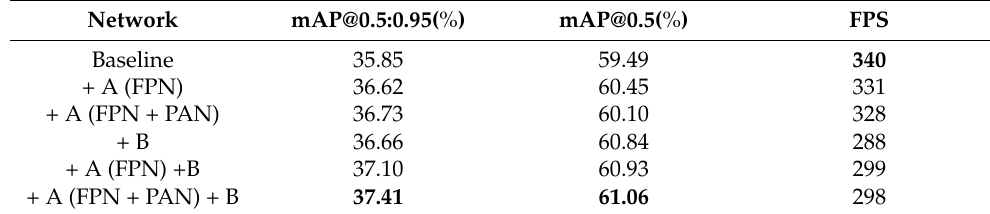
Table 4. Results of ablation experiments in the VOC dataset.